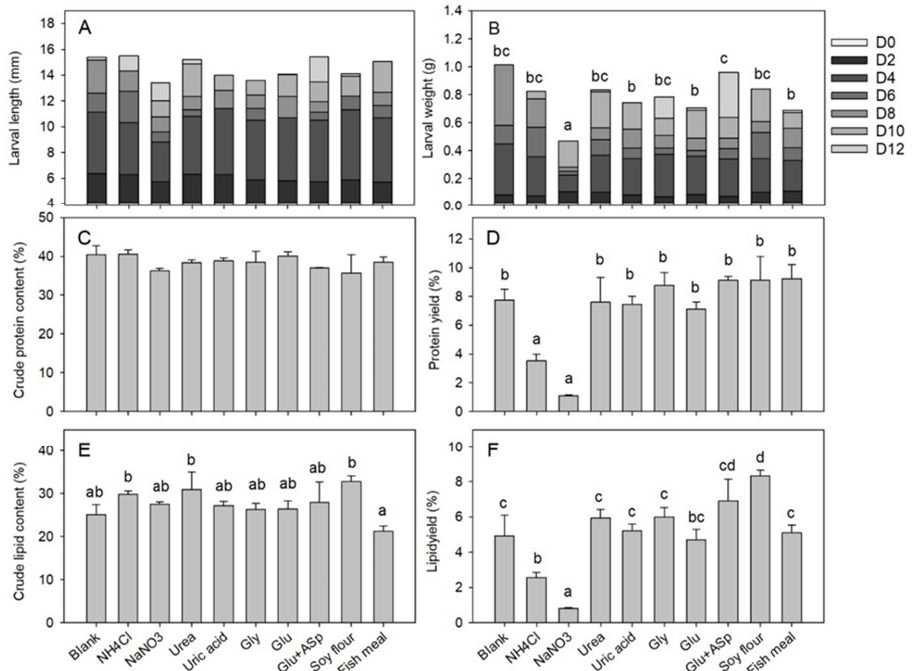
Figure 1. Larval growing and nutrient properties following nitrogen source amendment in Trial 1. Error bars represent standard deviations ( n = 3). The ( A ) larval body length and ( C ) crude protein content show no significant differences among groups. The ( B ) larval body weight ( p < 0.001), ( D ) protein yield ( p < 0.001), ( E ) crude lipid content ( p = 0.010), and ( F ) lipid yield ( p < 0.001) are different among groups, and groups with different letters represent significant difference ( p < 0.05).